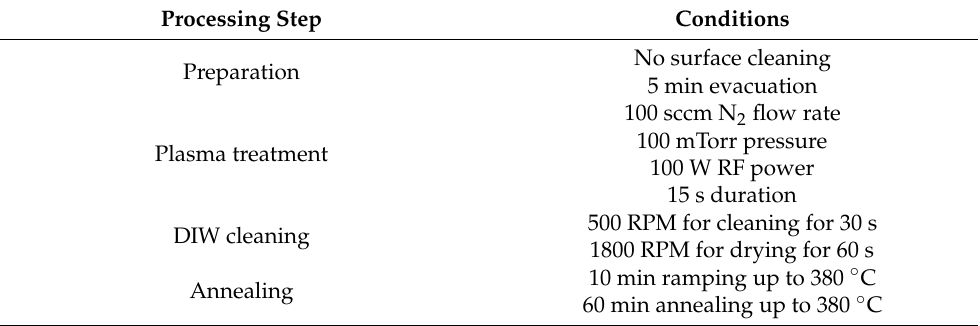
Figure 3. Bonding strengths obtained through an identical process under the same processing conditions normalized to the bonding strength with no plasma treatment. Table 1. List of the examined conditions for the reference conditions in the wafer bonding process.